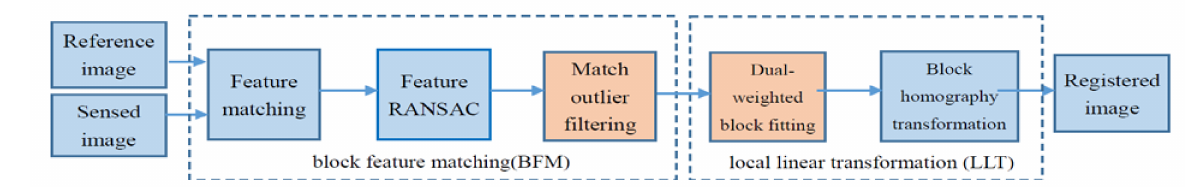
Figure 4. Block feature matching and local linear transformation method (BFM-LLT).